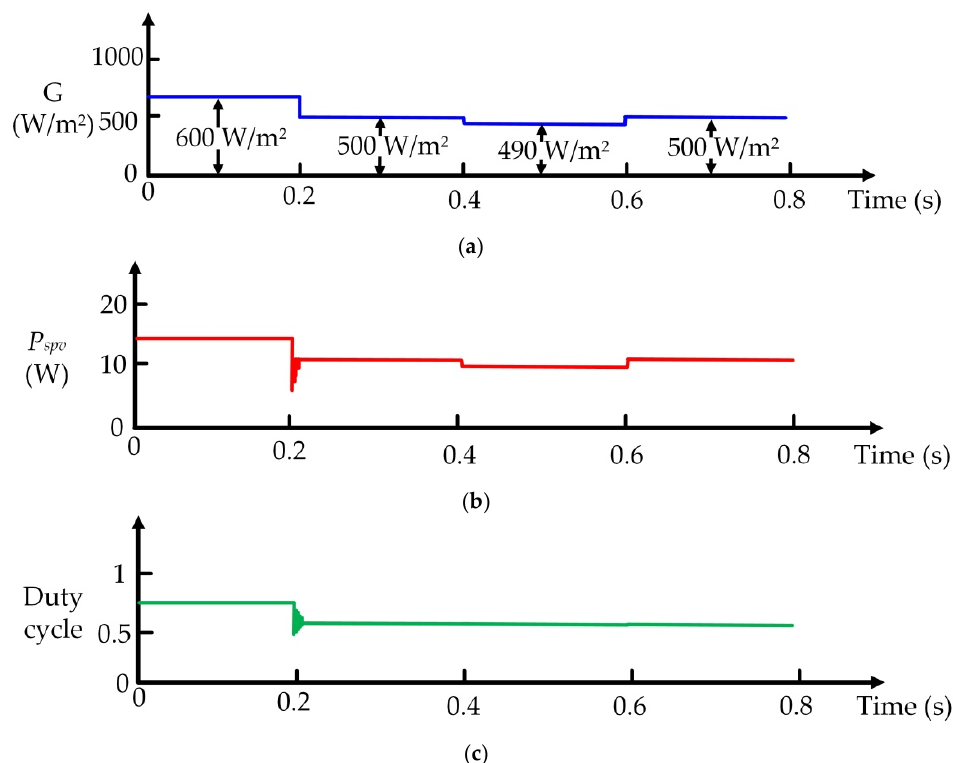
Figure 4. Corresponding SPV module for ( a ) solar radiation, G, (W/m 2 ), ( b ) SPV module output power, P spv , (W) and ( c ) duty cycle waveforms.